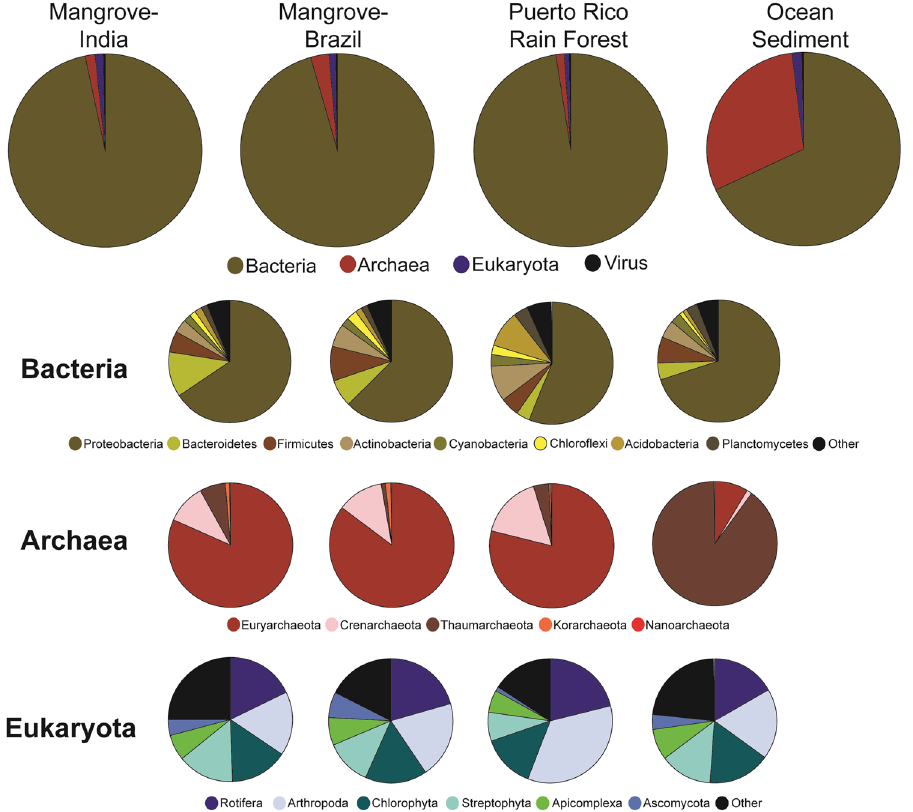
Figure 6. Taxonomic structure at the highest taxonomic levels across all samples. Averages of reads across samples from the same geographic location are pictured, with diversity at the kingdom level (large circles), different phyla within those kingdoms (smaller circles), and classes